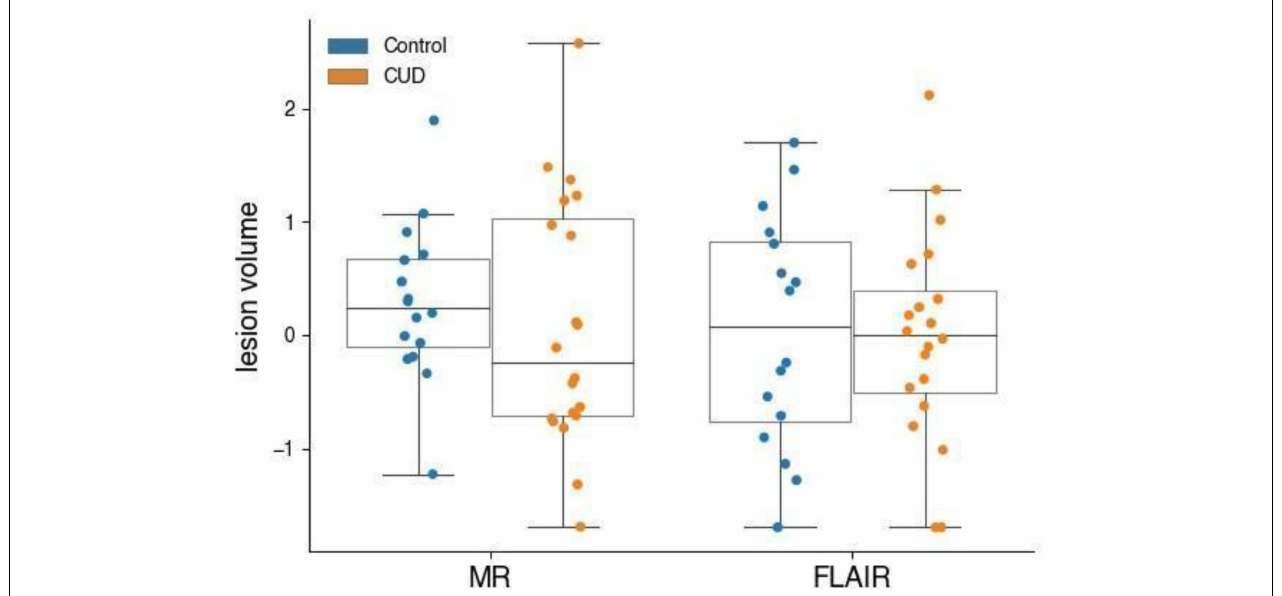
FIGURE 3 | MR and FLAIR lesion volumes (normalised) of participants who received a FLAIR scan. CUD patients ( n = 20) and control participants ( n = 16) with microbleeds who received a FLAIR do not have measurably different microbleed lesion